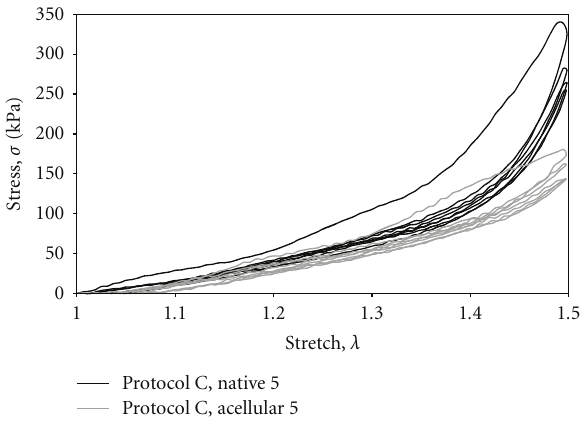
Figure 2: Example of hysteresis in native and acellular tissue samples for 4 load-unload